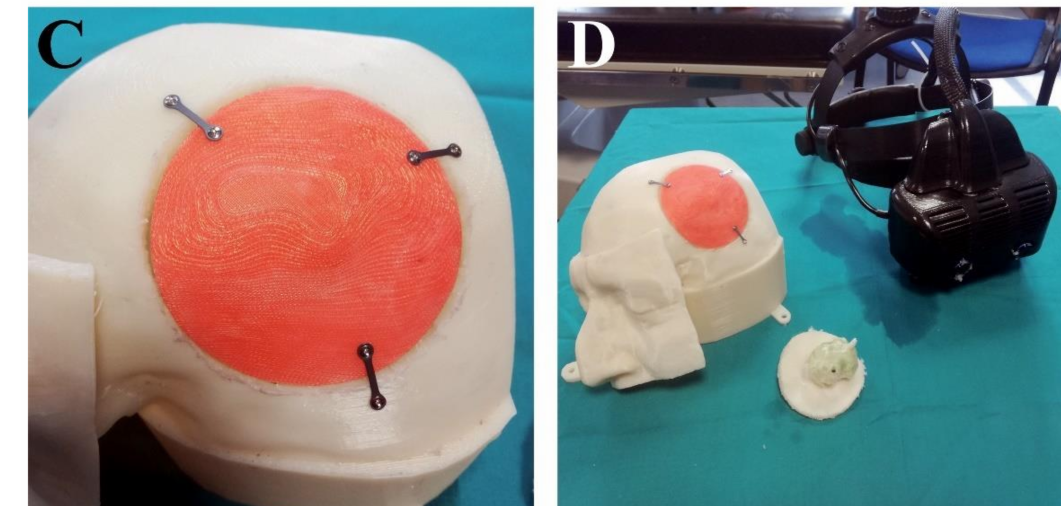
Figure 8. ( A ) The neurosurgeon drew the craniotomy line on the manikin’s head with a pencil by following the augmented reality craniotomy line. ( B ) Shows the craniotomy that was performed. ( C ) Shows there was no gap between the previously prepared custom-made bone flap and the manikin’s head, demonstrating an error of less than ± 1 mm in task execution. ( D ) The VOSTARS HMD and the manikin’s head with the new bone